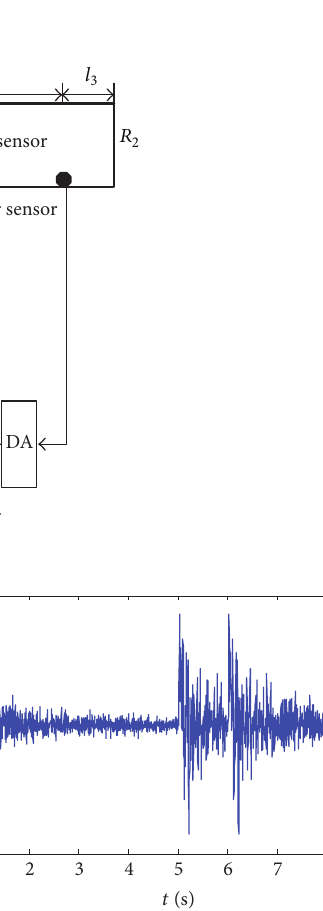
Figure 4: Block diagram of the proposed multiple model switching control system.